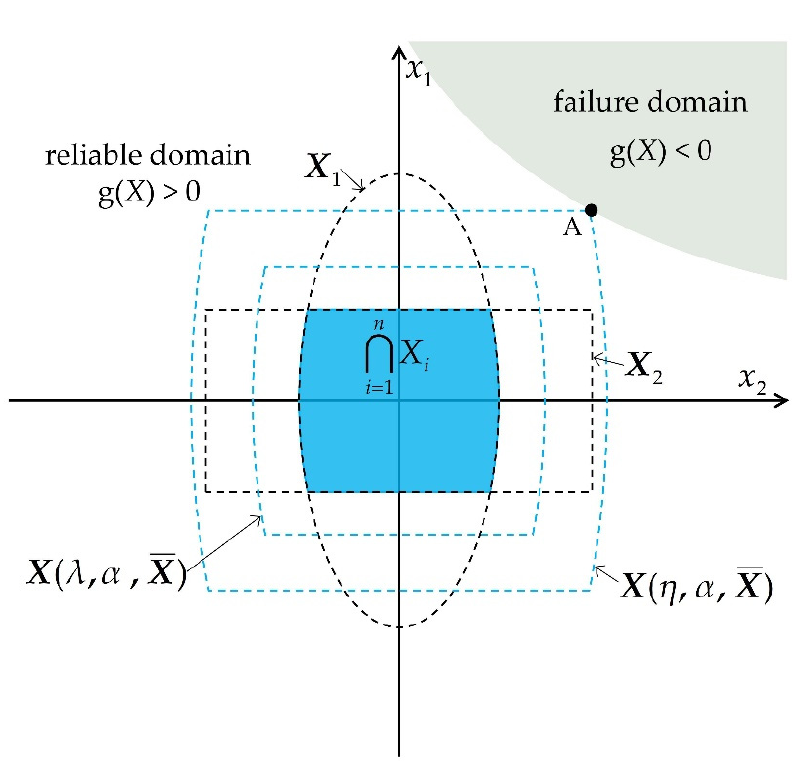
Figure 1. Schematic of the non-probabilistic reliability index based on a convex set model. The scaling factor of the convex set is used to obtain the optimization formula of η